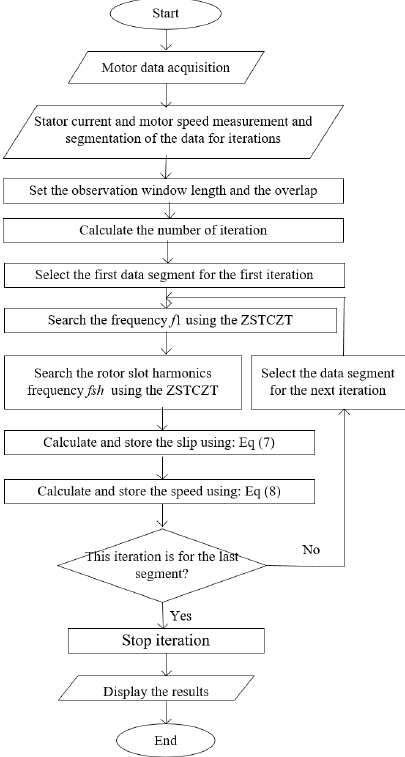
Figure 3. Flowchart of the proposed technique.